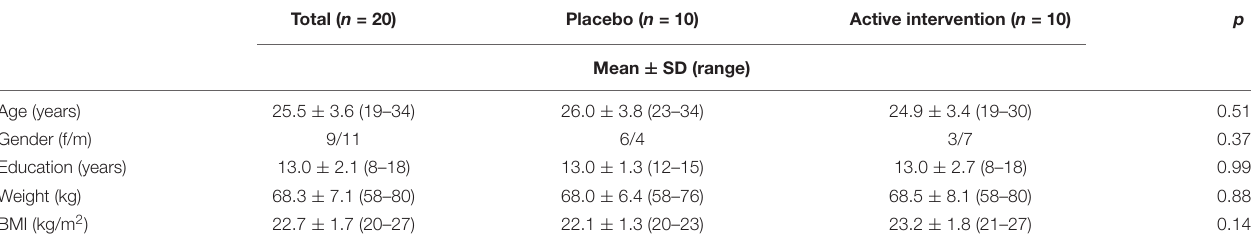
TABLE 1 | Sociodemographic and baseline characteristics of the